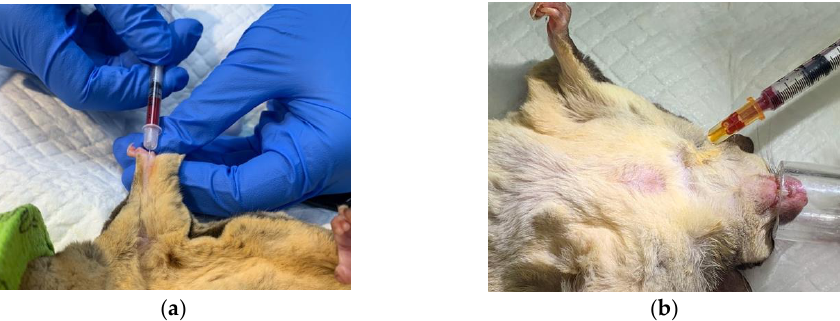
Figure 2. Two of the blood collection sites used in this study. ( a ) Median artery, using 0.3 mL insulin syringe; ( b ) cranial vena cava, using 1 mL syringe.